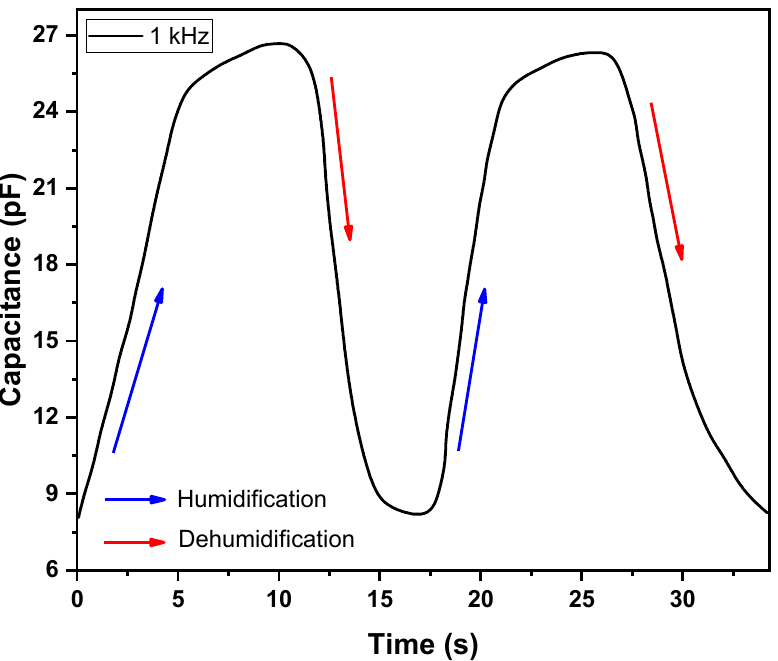
Figure 8. Response time and recovery time cycles of the Ag/F8-Cu 2 O/Ag sensor at 1 kHz.